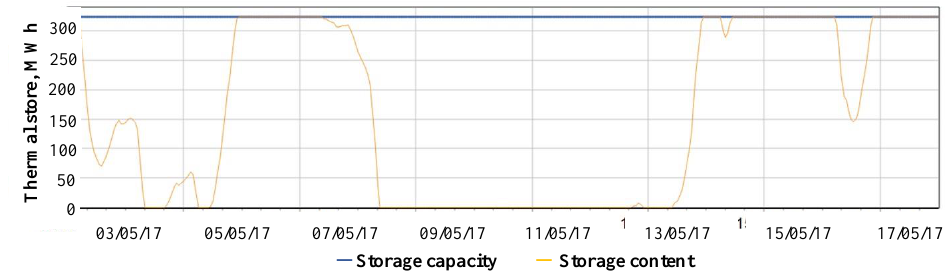
Fig. 6. Example of an accumulator tank (7000 m 3 ) charging and discharging for scenarios A and